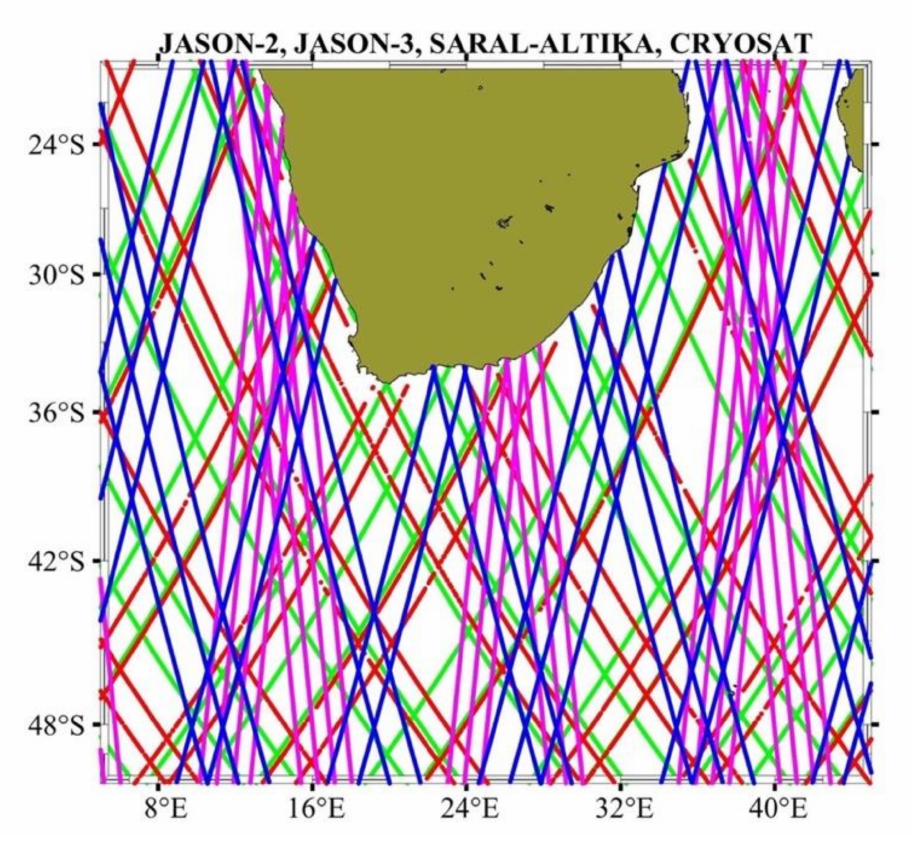
Figure 2. Orbit segments of Jason–3 ( green ), Jason–2 ( red ), Saral–Altika ( blue ) and Cryosat ( magenta